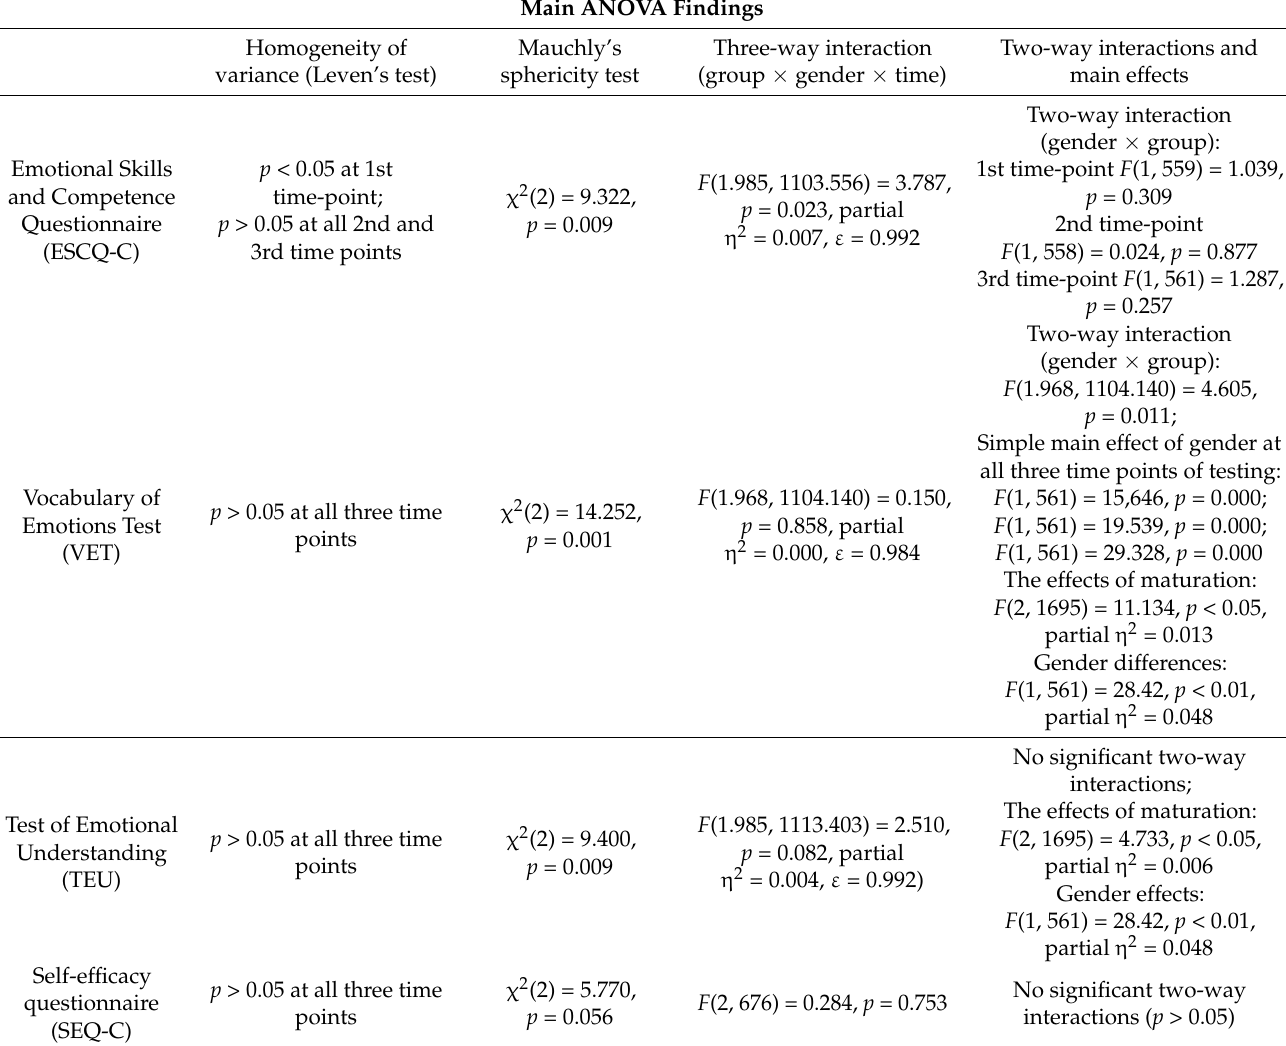
Table 5. Main ANOVA findings. Main ANOVA